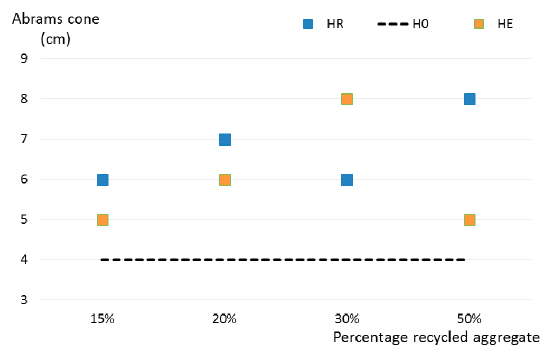
Figure 4. Consistency of manufactured concrete.